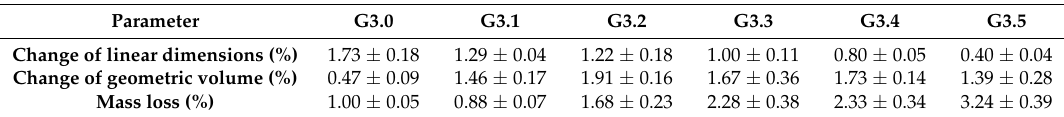
Table 5. The aging tests